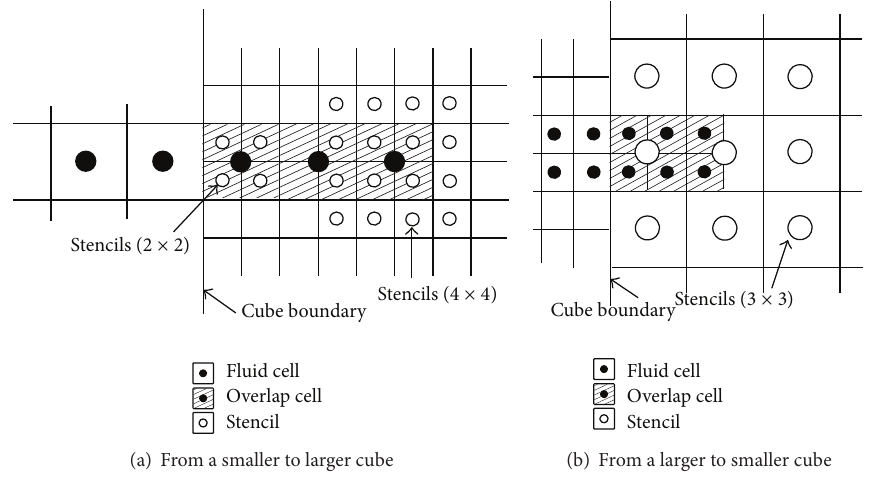
Figure 4: Stencils used for Lagrange interpolation in two dimensions.